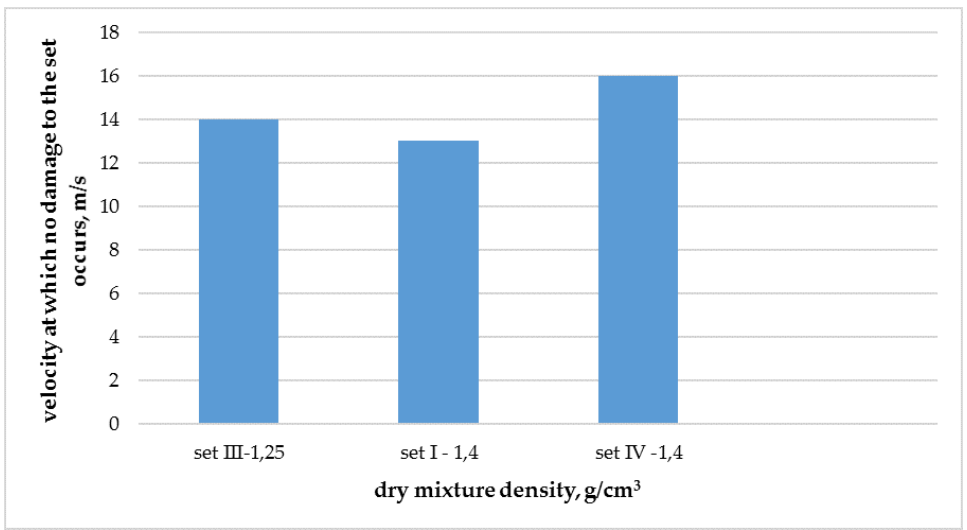
Figure 8. Comparative specifications of resistance to hail puncture and density of cement-based dry mixture used for making the reinforcement layer.